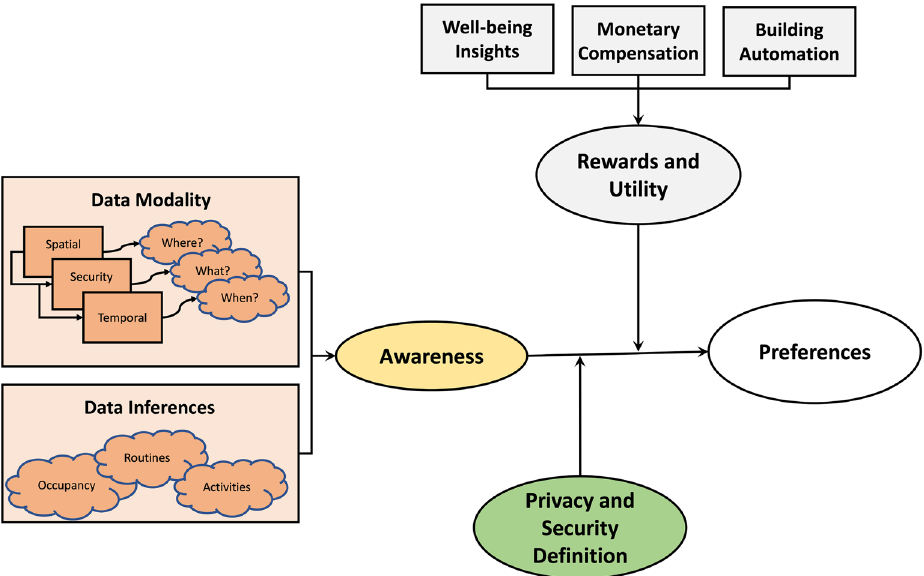
Figure 5. People’s privacy preferences are composed of data modality features and personal features. Data modality features and data inferences contribute to the individual’s awareness. One’s awareness, definitions of privacy and security, and the rewards and utility make up the personal